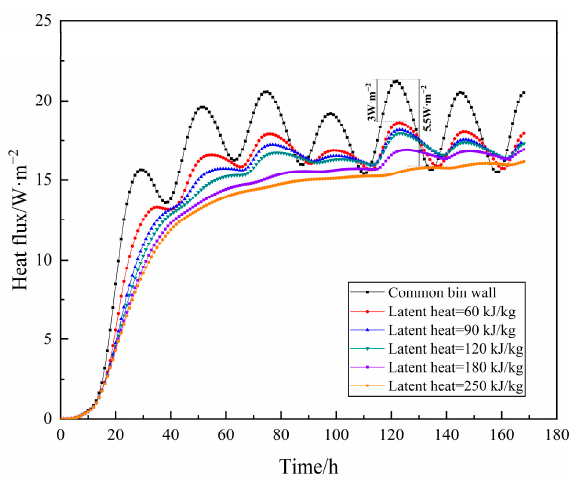
Figure 6. The interior heat flux of PCM bin wall.